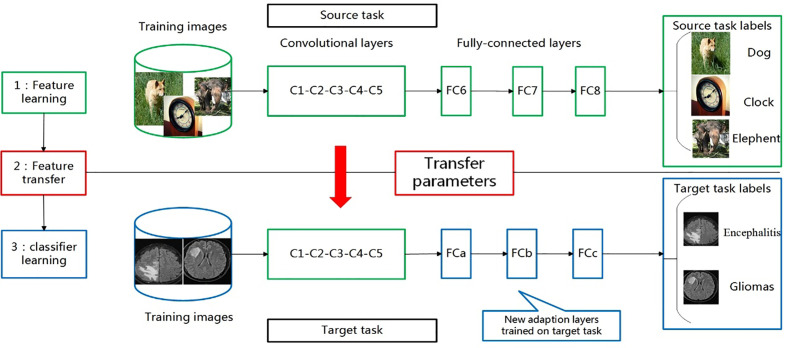
Transferring parameters of convolutional neural network (CNN). First, network is trained on source task (ImageNet classification, top row) with large amount of available labeled images. Then, convolutional layers (C1-C5) are transferred to target task(brain tumour and encephalitis classification, bottom row). We remove original fully connected layers (FC6-FC8) and add adaptation layer (FCa-FCc). Last, we fine-tune new model on labeled data of target task.